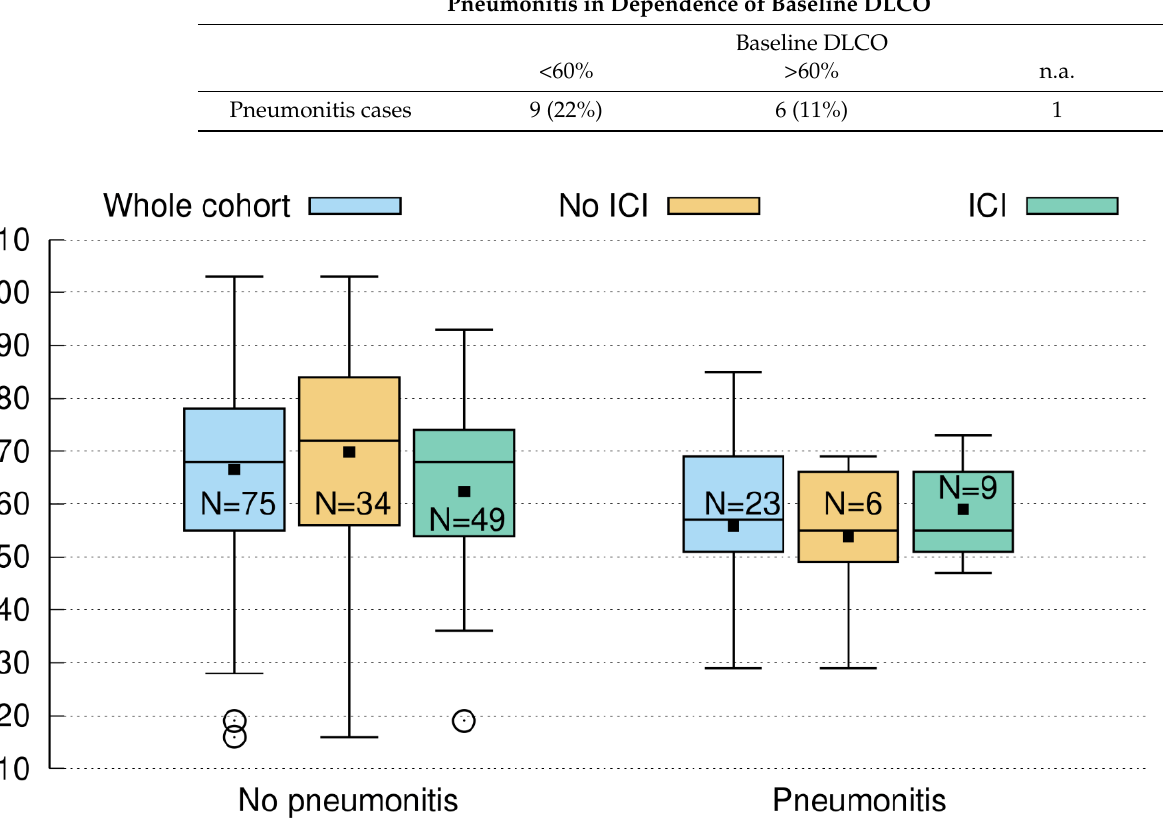
Figure 1. Pre-treatment DLCO (=carbon monoxide diffusing capacity) predicts the occurrence of clinically relevant pneumonitis, which was significant in the whole cohort (blue: n = 98; one-sided Pearson correlation coefficient 0.175; p -value = 0.042) and in the subcohort without ICI (= immune checkpoint inhibitor) shown in the brown boxplot ( n = 40; one-sided Pearson correlation coefficient 0.288; p -value = 0.036). In patients with ICI (green), no such correlation could be found (n = 58; one-sided Pearson correlation coefficient 0.092; p -value = 0.245). Table 4. Clinically relevant pneumonitis in dependence of baseline DL CO . If baseline DL CO was <60%, the probability of clinically relevant pneumonitis was approximately twice as high as in patients with DL CO above this threshold (n.a. = not assessable).